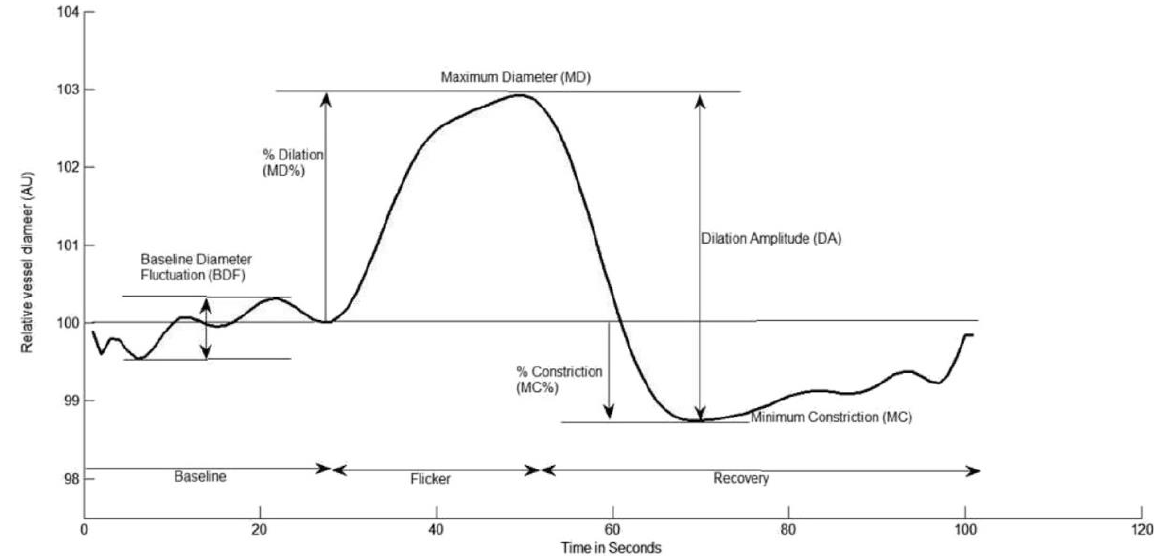
Figure 1. Graphical presentation of the dynamic vessel response profile displaying the parameters calculated and used in analysis. (DA) calculated as (MD-MC). (MD%) calculated as the percent increase from baseline to MD. (MC%) calculated as the percent constriction below baseline following MD.